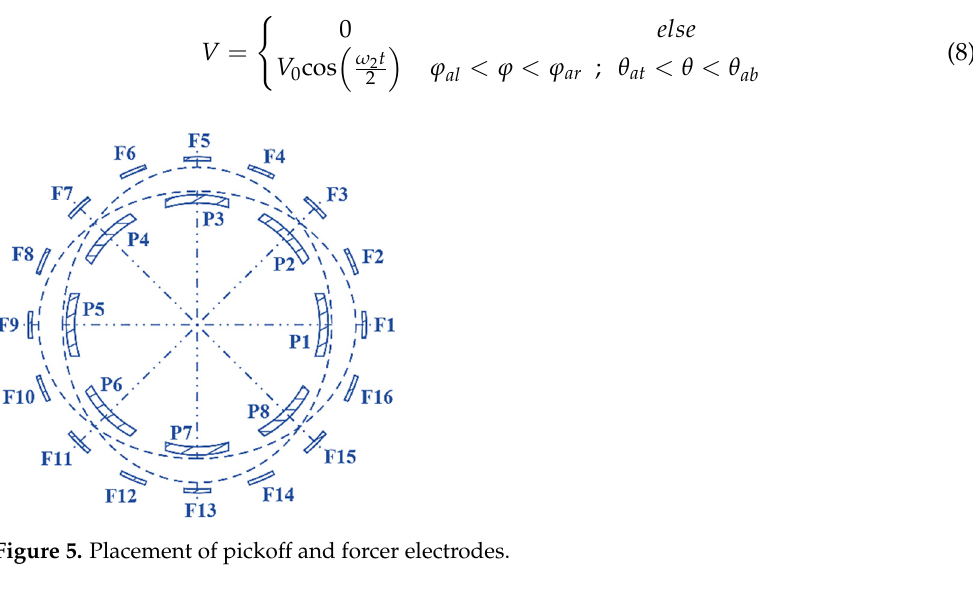
110 Table 3. Position of pickoffs on HRG. Electrode